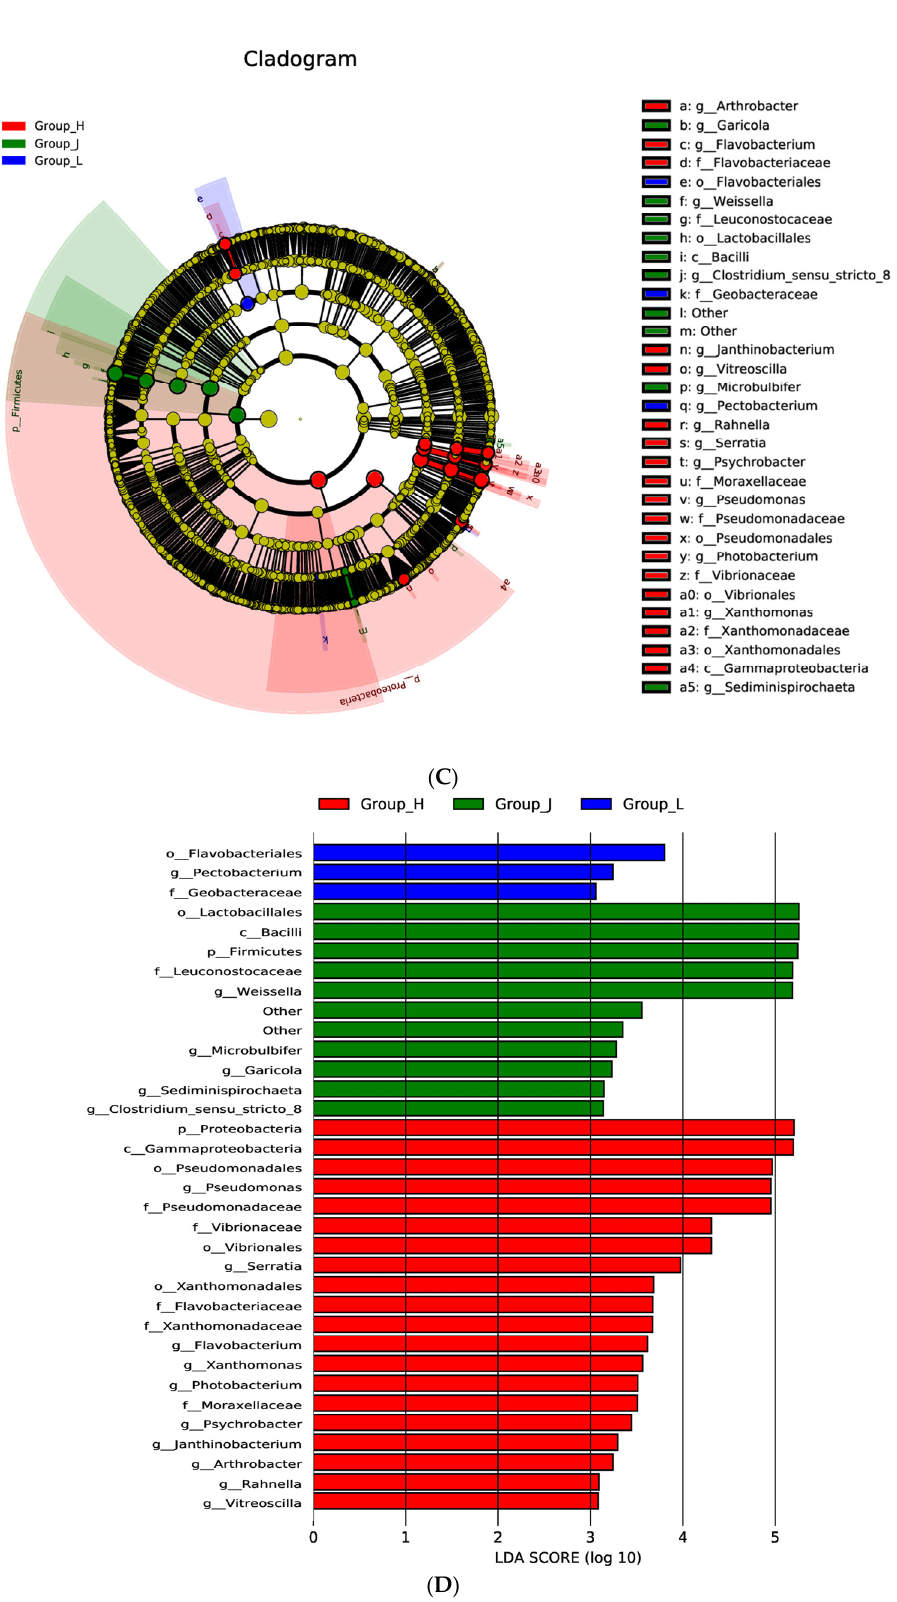
Figure 3. ( A , B ): Non-metric multi-dimensional scaling (NMDS) of the data set (24 samples). LEFSE ( C ) and Linear discriminate analysis ( D ) of the bacterial community in the CSC of different provinces (Group_P: retail- produced, Group_C: home-made; Group_J: Jilin Province, Group_L: Liaoning Province, and Group_H: Heilongjiang Province).